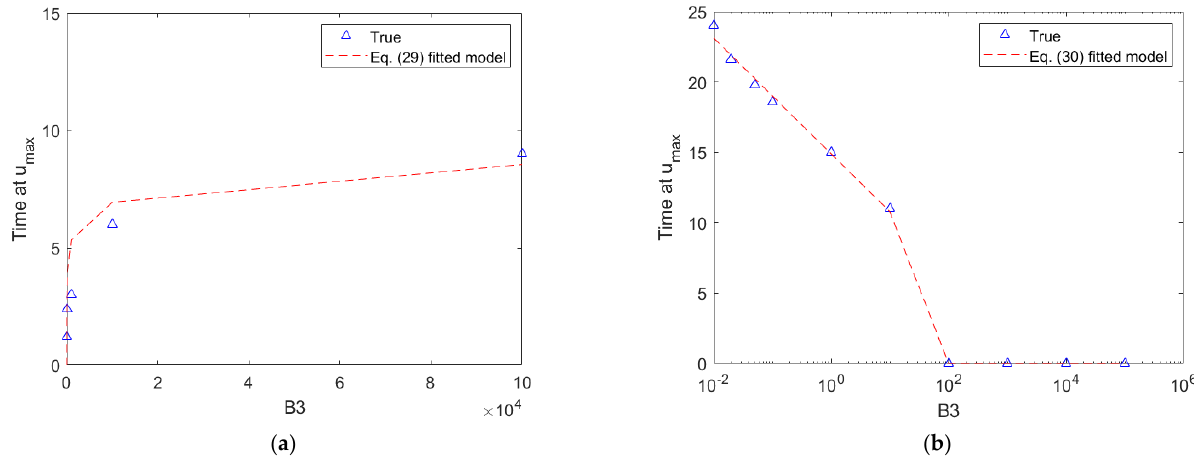
Figure 22. The t max times required for both control efforts in the application of Policy 3, for the change of B 3 weightings of Equation (27). ( a ) Control effort u 1 ; ( b ) Control effort u 2 .